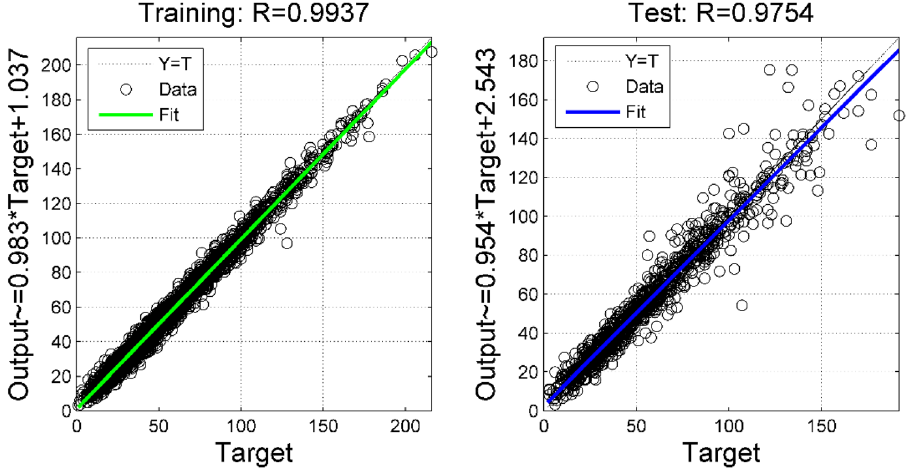
Figure 7. The prediction effect of PM 2.5 ’s PCA–RVM–NAR model on the training set and test set.